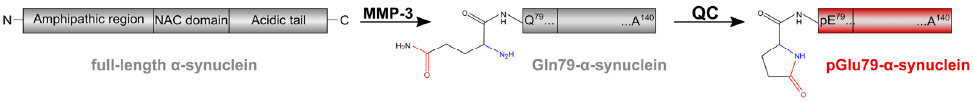
Figure 1. Schematic representation of sequential enzymatic pGlu79-aSyn formation. MMP-3 catalyzes proteolytic cleavage of full-length aSyn resulting in Gln79-aSyn as one fragment among several cleavage products. Gln79-aSyn then serves as precursor for QC-catalyzed pGlu79-aSyn formation (red). Data on aSyn cleavage by MMP-3 from [25,26]. Data on Gln79-aSyn conversion into pGlu79-aSyn by QC from [21] .